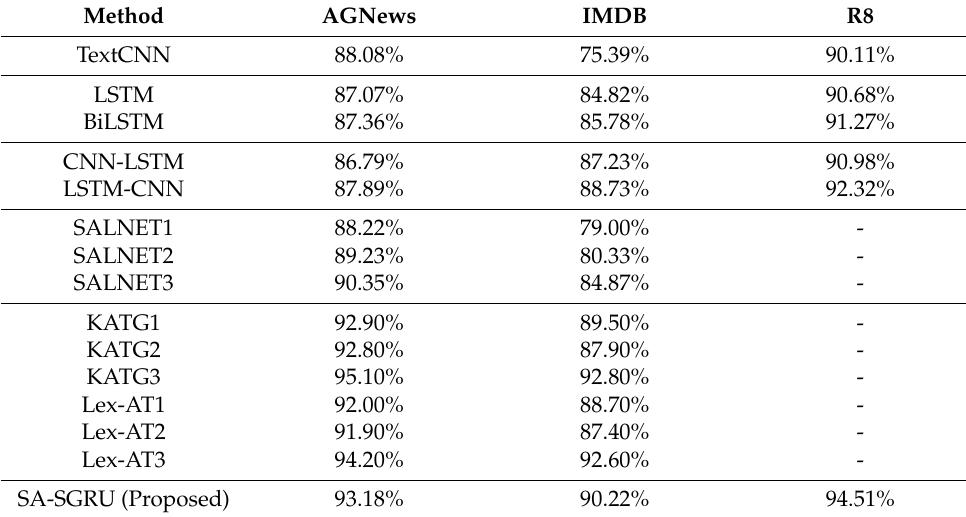
Table 3. The main experimental findings